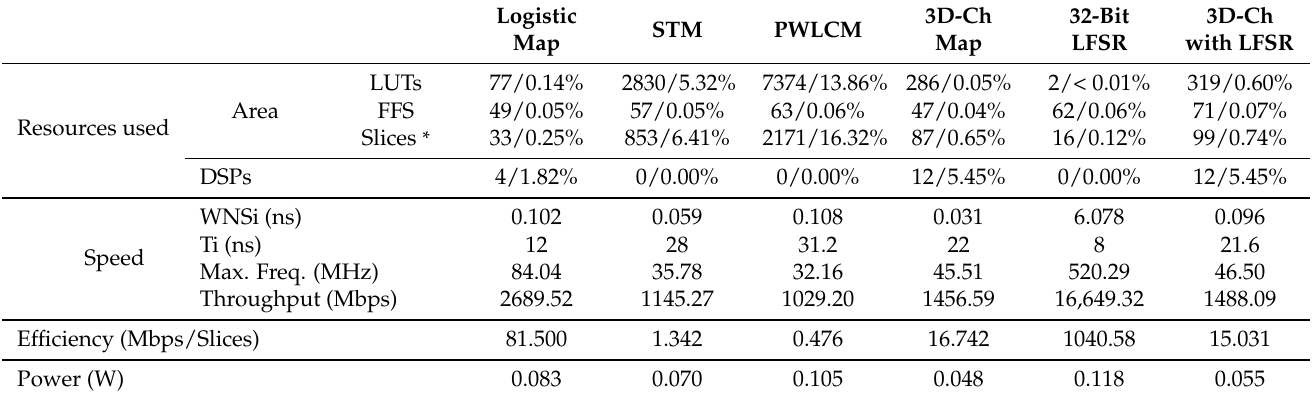
Table 2. Hardware metrics of studied chaotic maps, the 32-bit LFSR, and the 3D-Chebyshev map coupled with the 32-bit LFSR. Logistic Map